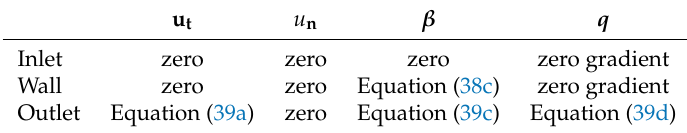
Table 3. Adjoint boundary conditions, using objective function Equation